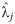
RECC of accidents in Central London between 2005 and 2014.A: The accident rate (λ^j) and group sizes (q^j). B: Cumulative accident rates (blue) and the Lorenz curve (in yellow). The RECC is represented by (twice) the area between the two curves.